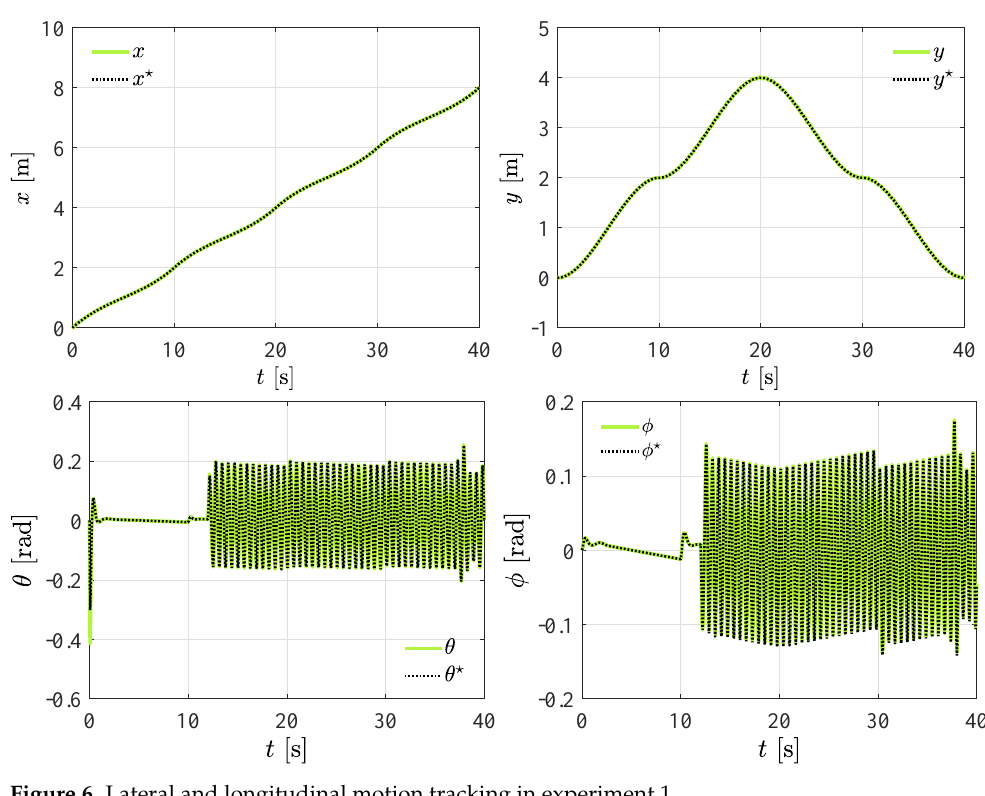
Figure 6. Lateral and longitudinal motion tracking in experiment 1.